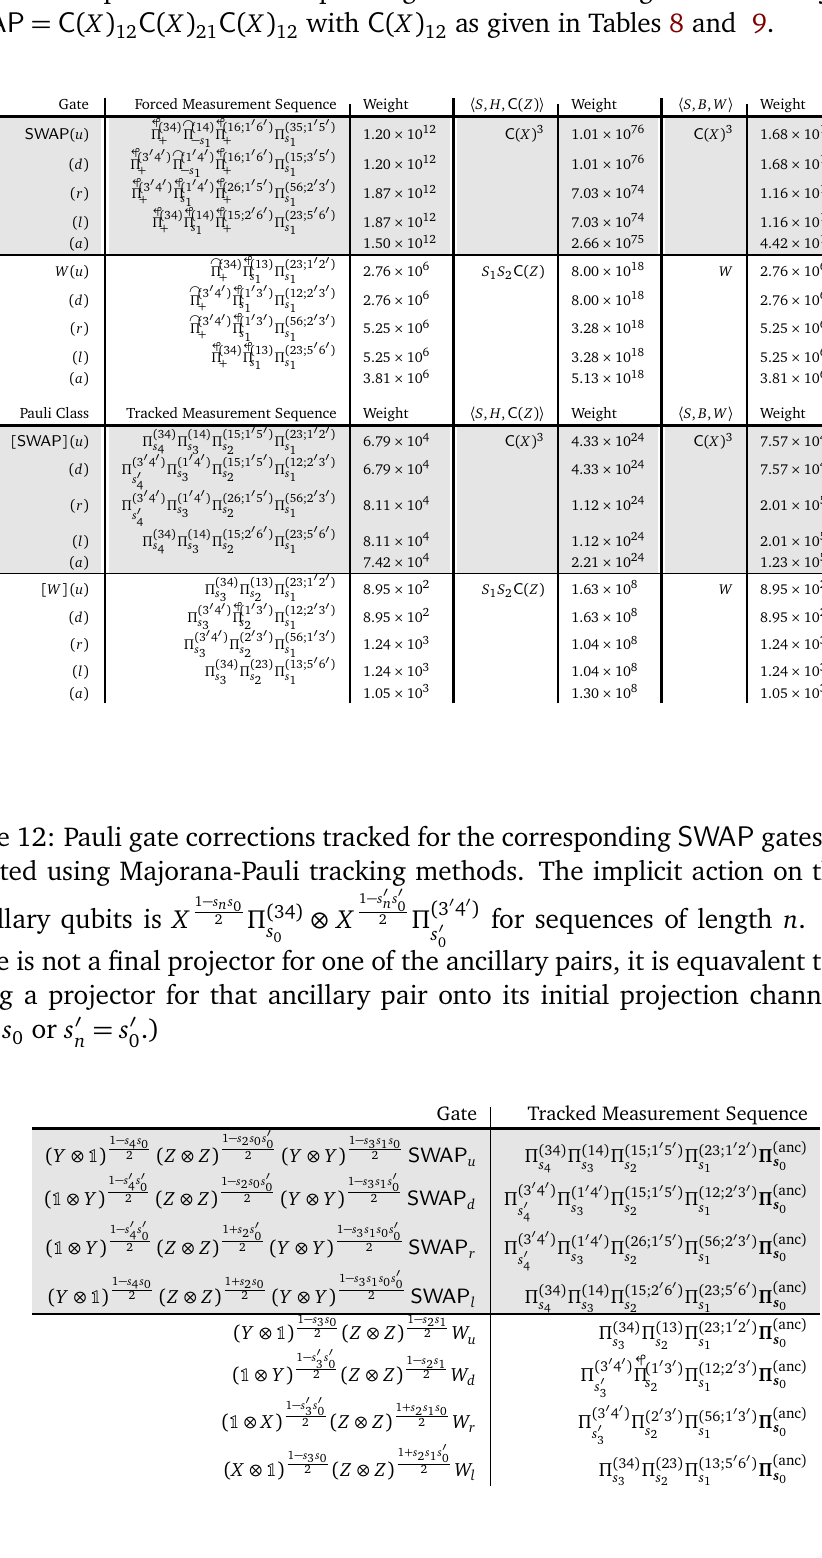
Table 11: Minimal difficulty weight measurement sequences for the two-qubit SWAP and W gates when using forced-measurement methods and the Pauli cosets of SWAP and W when using Majorana-Pauli tracking methods. For compari- son, we also present the corresponding realization of the gates formed by using SWAP = C ( X ) C ( X ) C ( X ) with C ( X ) as given in Tables 8 and 9. 12 21 12 12